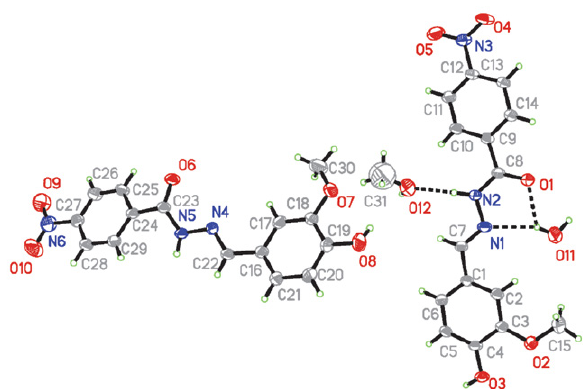
Figure 1. A perspective view of the molecular structure of 1 show- ing the atomic labeling scheme. The thermal ellipsoids are drawn at the 30% probability level. The hydrogen bonds are shown as a dashed